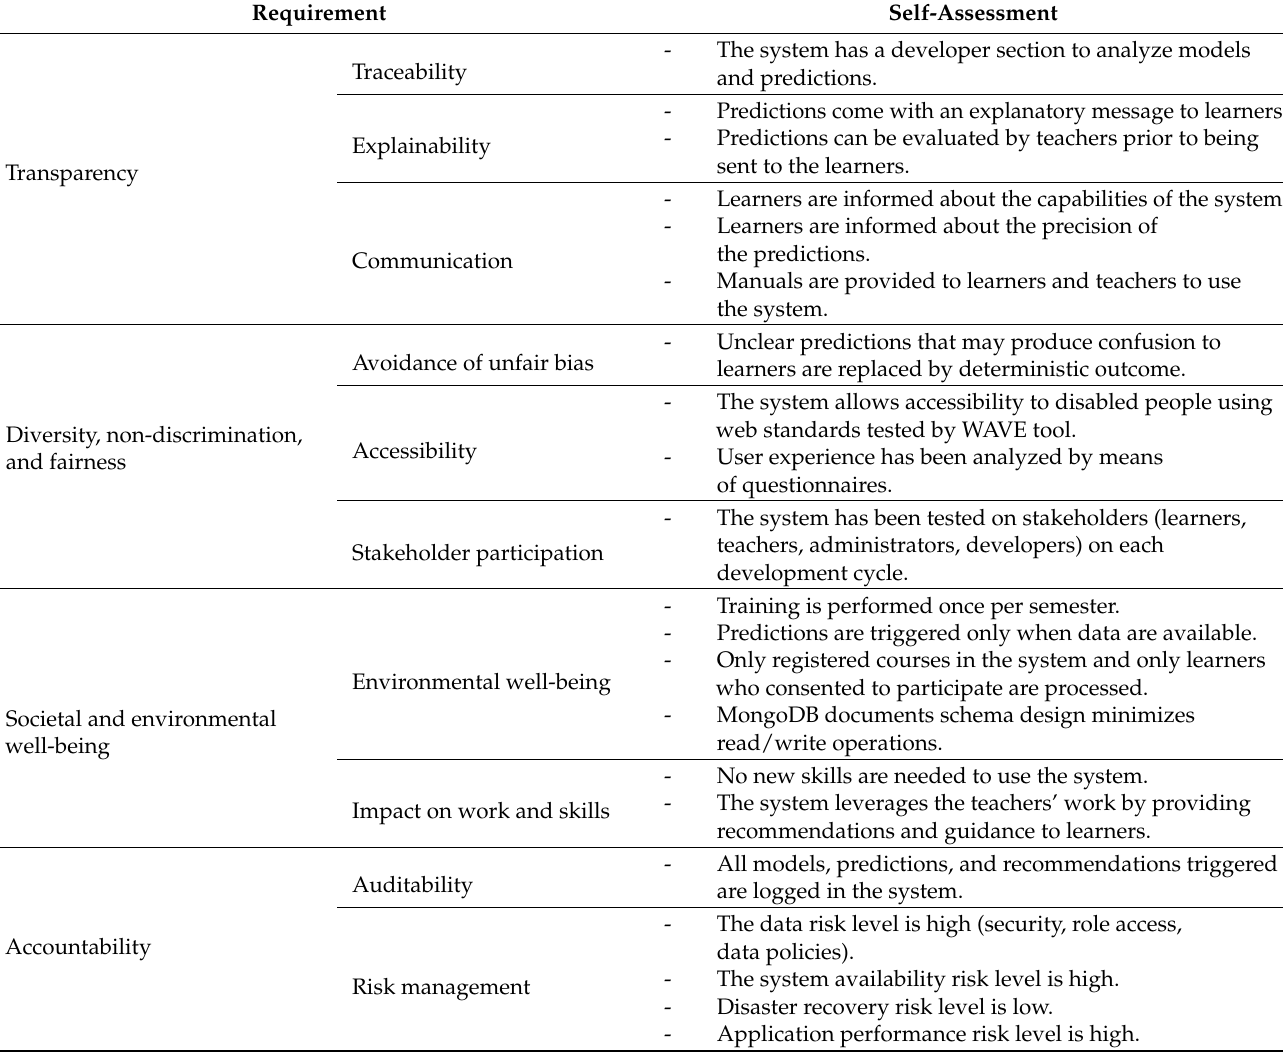
Table 2. Self-assessment of the ALTAI guidelines